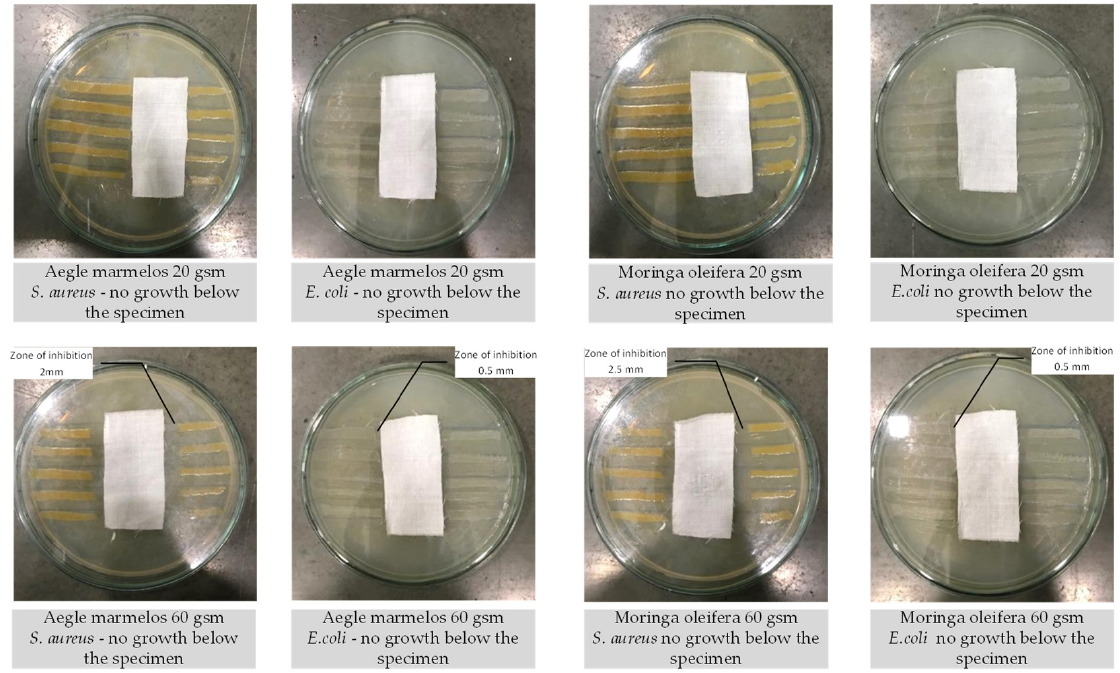
Figure 8. Antimicrobial tests AATCC 147:2016 parallel streak method.